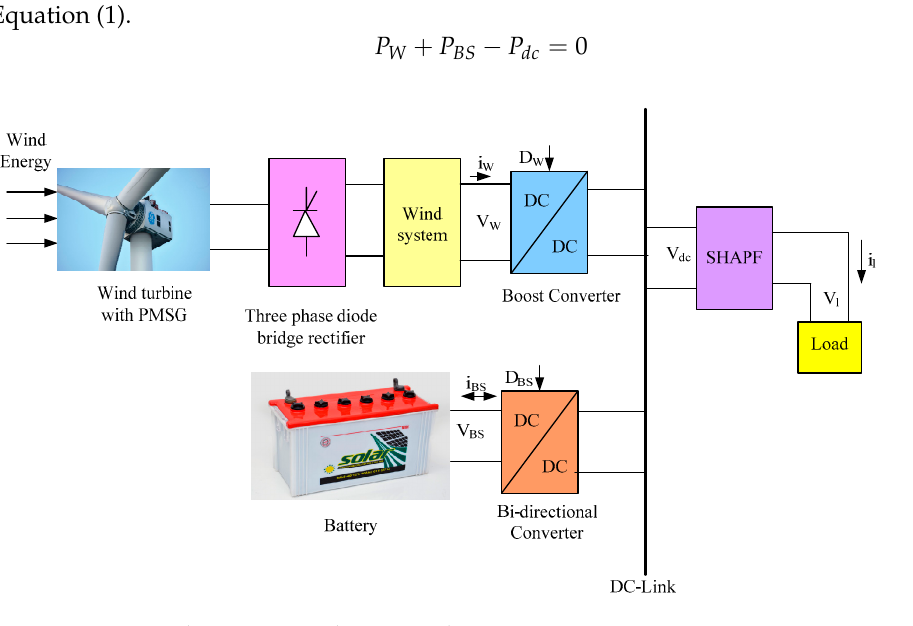
Figure 2. WPGs and BSS connected to DC-Link.